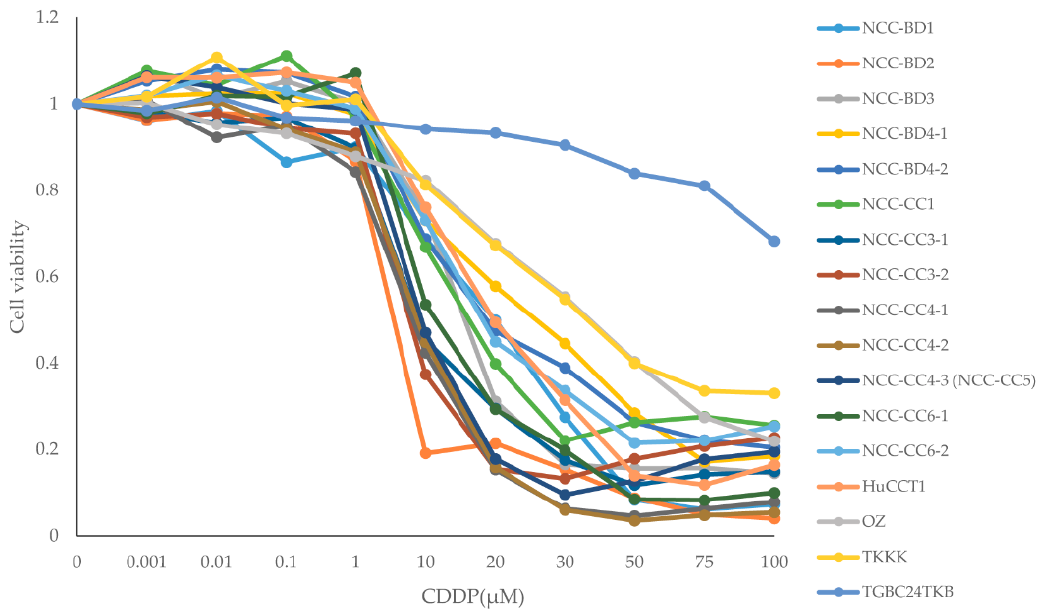
Figure 1. Dose–response curves of biliary tract carcinoma cell lines for cisplatin (CDDP) single administration. The dose–response curves for each cell line were used to calculate IC50